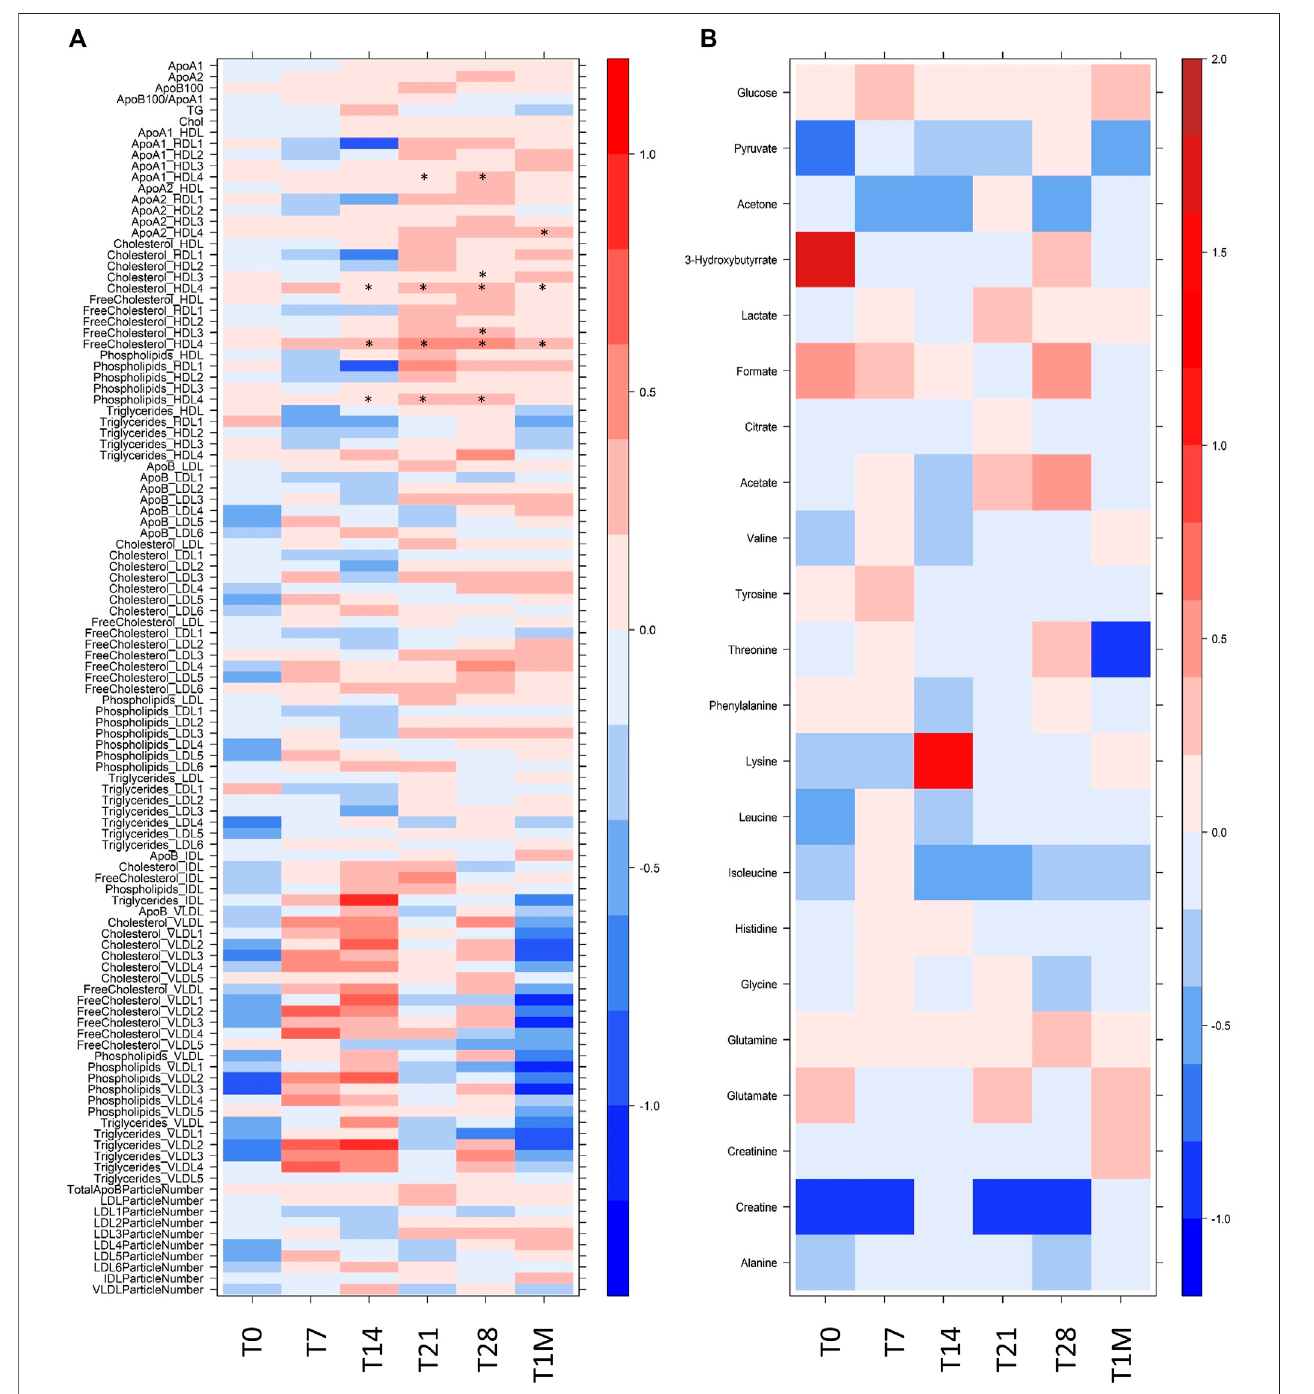
FIGURE 2 | Level plot of Log 2 (FC) of (A) lipoprotein related parameters and (B) metabolites; red/blue values indicate higher/lower concentration at T0, T7, T14, T21,T28andT1MsamplesofCOVID-19-recoveredgroupwithrespecttoCOVID-19-naïvegroup.ThebrightnessofeachcolorcorrespondstothemagnitudeoftheFC. Asterisks indicate statistical signi fi canceThe level plot has been created using the function levelplot implemented in the R package “ Lattice ” .